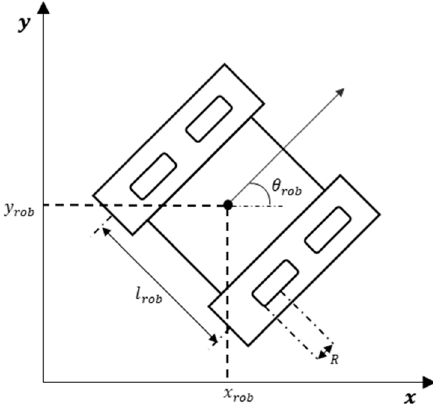
Figure 1. Schematic diagram of the crawler robot.